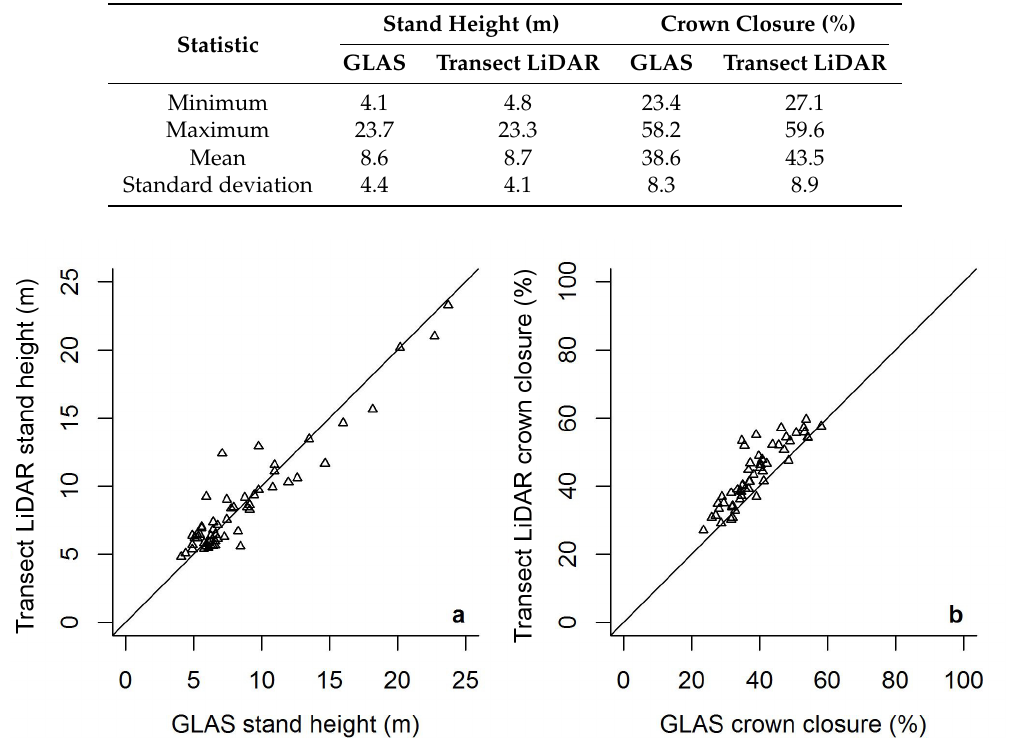
Figure 4. Comparison of Geoscience Laser Altimeter System (GLAS) modelled ( a ) stand height and ( b ) crown closure with 55 coincident transect LiDAR